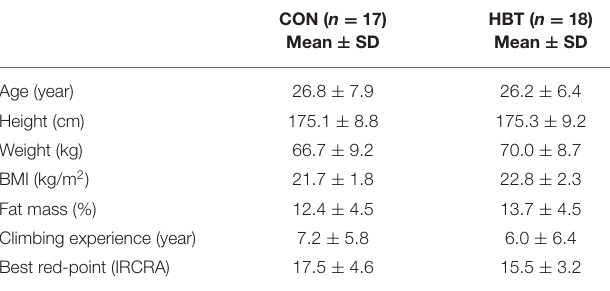
TABLE 1 | Descriptive